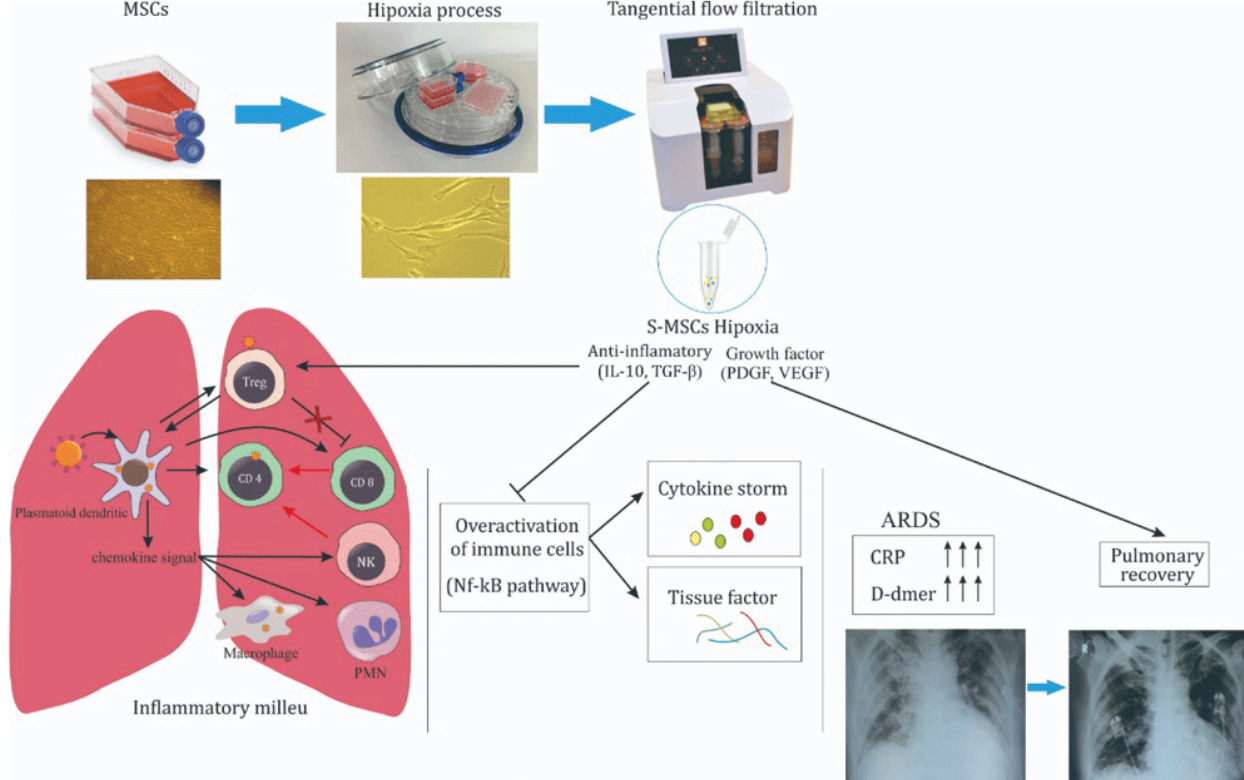
Figure 2. Schematic of cytokine storm on severe COVID-19 treated by S-MSCs. MSCs were incubated in 5% O S-MSCs was isolated from the culture medium using TFF technique 12 . S-MSCs contain soluble molecules, including IL-10, TGF-β, PDGF and VEGF. IL-10 and TGF-β inhibit NF-kB pathways activation of overactivated immune cells leading to cytokine storm inhibition, characterized by the decreased level of CRP and D-dimer. Under controlled inflammatory milieu, VEGF and PDGF promote the improvement of bilateral GGOs marked by pulmonary